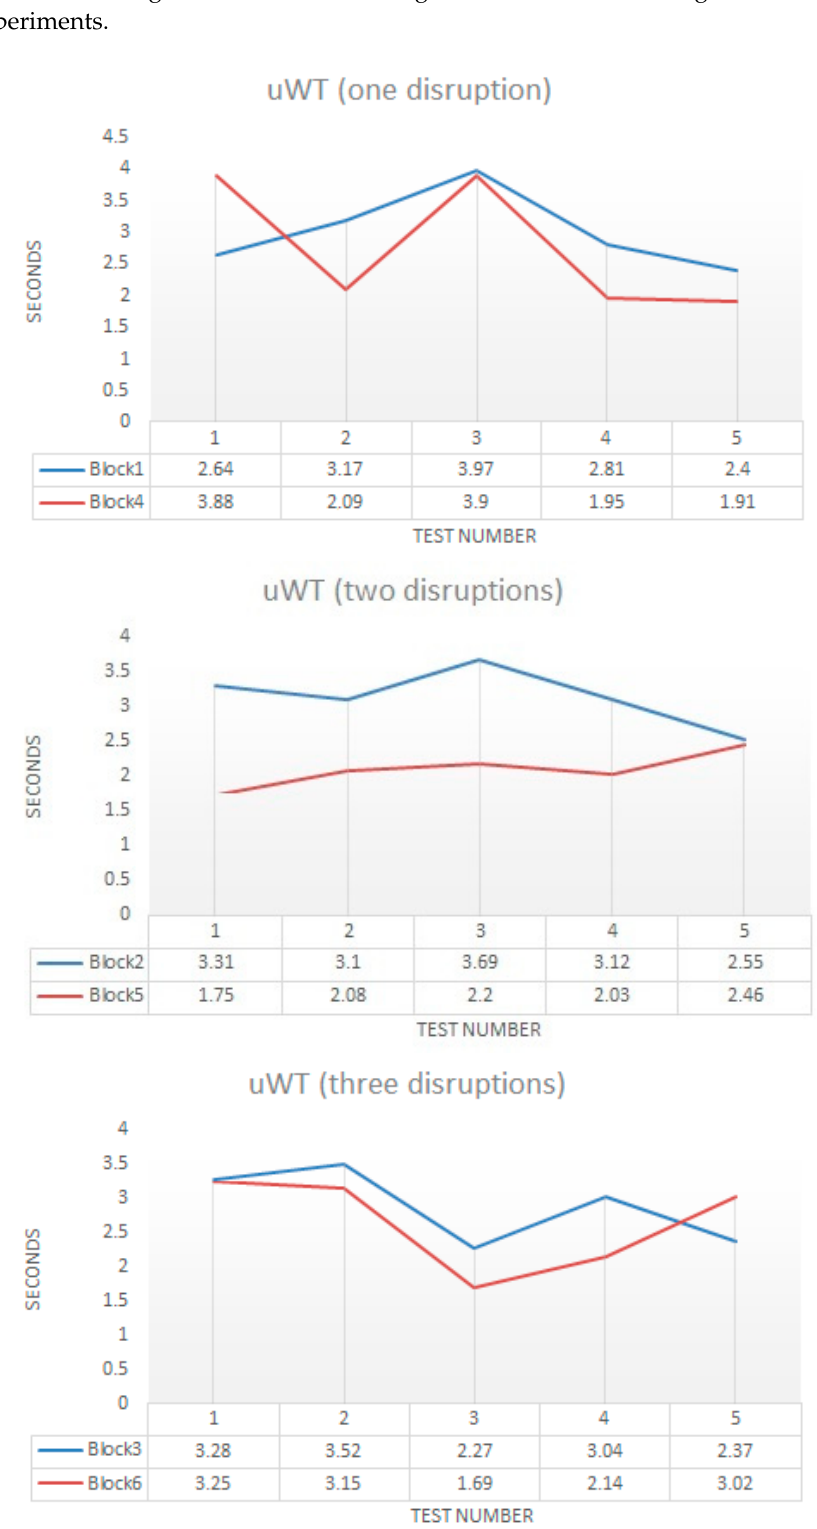
Figure 14. Values of uWT for one, two and three disruptions in the WTerm1 and WTerm2.